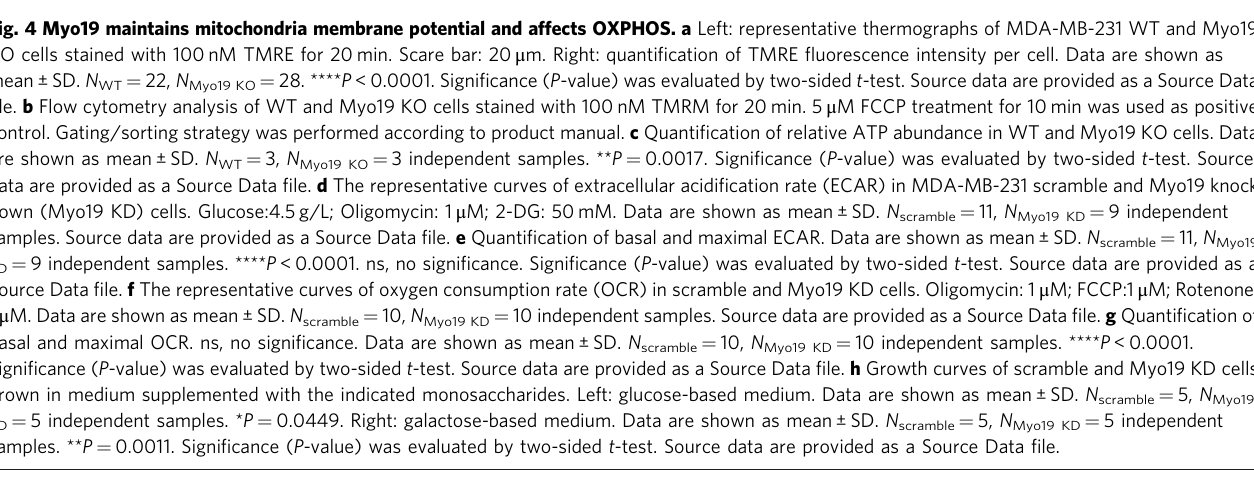
Antibodies and reagents . The following antibodies were used in this study: rabbit anti-Myo19 (HPA059715, 1:1000 for western blotting) from Sigma-Aldrich; rabbit anti-Mic60 (A2751, 1:3000 for western blotting), anti-Metaxin2 (A7958, 1:1000 for western blotting) and rabbit anti-Sam50 (A3401, 1:3000 for western blotting, 1:400 for PLA assay) from ABclonal; mouse anti-Mic60 (sc-390707, 1:200 for immu- no fl uorescence staining) from Santa Cruz Biotechnology; rabbit anti-GFP (598, 1:1000 for western blotting, 1:200 for immuno fl uorescence staining) and mouse anti-GFP (MO48-3, 1:200 for immuno fl uorescence staining) from MBL; anti- mouse (sc-516102, 1:4000) and anti-rabbit (sc-2004, 1:4000) horseradish perox- idase (HRP)-conjugated secondary antibodies from Santa Cruz Biotechnology; Alexa Fluor488- or Alexa Fluor 555-conjugated secondary antibody from Ther- moFisher Scienti fi c. For reagents, MitoTracker TM Red CMXRos (M7512), Mito- Tracker TM Green FM (M7514), TMRE (T669), TMRM (T668) and Prolong Diamond Antifade with DAPI (P36962) were purchased from Thermo Fisher Scienti fi c. Rotenone (HY-B1756), FCCP (HY-100410) and 2-Deoxy-D-glucose (HY-13966) were purchased from MedChemExpress. Plasmid constructions . The full length human Myo19, Sam50, MTX2, MTX3 were cloned from the MDA-MB-231 cell-extracted cDNA library and was sub- cloned into lentiviral vector (Plvx-ac-GFP-N1) with C-terminal tagged EGFP using an ABclonal MultiF Seamless Assembly kit (RK21020, ABclonal). The Myo19 truncations were ampli fi ed and cloned into the same vectors. The FL-Myo19 (1- 970 aa), Δ Tail (1-823 aa) and Δ Motor-3IQ (824-970 aa) were constructed. Generation of knockout and knockdown cells . For gene knockout, the following sgRNAs in LentiCRISPR-V2 (#52961, Addgene) were used in MDA-MB-231 cells. After puromycin selection, the single cell clones were cultured and veri fi ed by sequencing and western blotting. For Myo19 knockout: sgRNA-1: 5'-ATGGTACTCTCTCATTAGCT-3'; sgRNA-2: 5'-GACACATTCTACACCAATGC-3'. Sequencing primer: Myo19-seq-F: 5'- TATGGGCCTCCCATTCCTCA-3'; Myo19-seq-R: 5'- TCCCCACTTTGCACCTTCTG-3'; For Miro1 knockout: sgRNA-Miro1-1: 5'-GGCTGCCTTTAATATTGGTT-3'; sgRNA-Miro1-2: 5'-TCTGGTGGAATATAGTAGTA-3'; Sequencing primer: Miro1-seq-F: 5'-GGGGCTCAACCTGACTGTAG-3'; Miro1-seq-R: 5'- TACCTCCTTCTCCTCTGGGC-3'; For Miro2 knockout: sgRNA-Miro2-1: 5'- TTCTCCGGGGTGACGTCCGC-3'; sgRNA-Miro2-2: 5'- ATGGTGATCTCCTCCGCGCG-3'; Sequencing primer: Miro2-seq-F: 5'- CCCGTCCCTTAATCGGCTG-3'; Miro2-seq-R: 5'- CCACTGGACTGAGCGGTG-3'; For Myo19 and Sam50 knockdown in MDA-MB-231 cells, the following shRNAs were cloned into pLKO.1 vector. After lentivirus infection and puromycin selection, the pooled cells were veri fi ed by the western blotting. scramble: 5'-AACGCTGCTTCTTCTTATTTA-3';